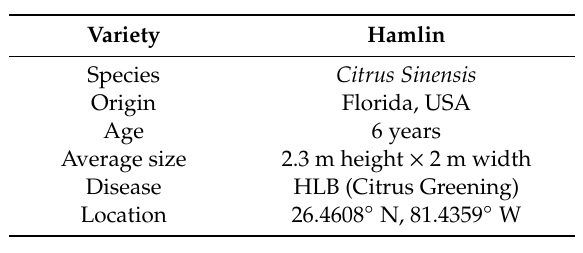
Table 3. Target tree